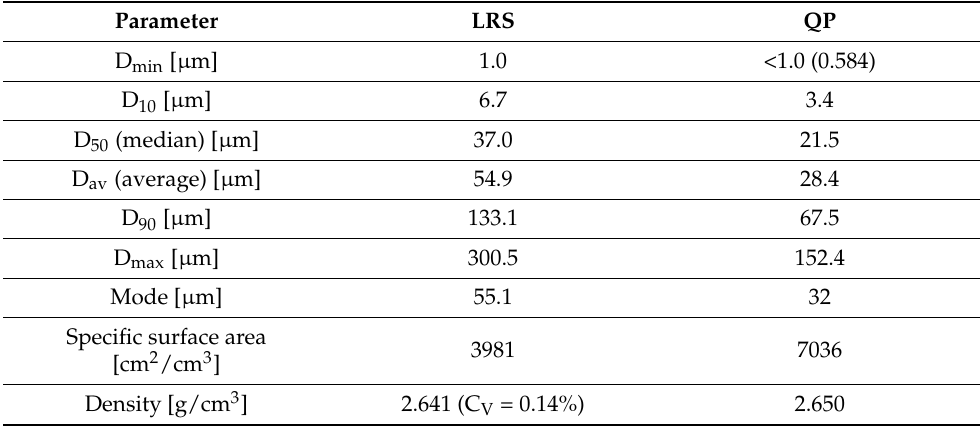
Table 4. Statistical parameters describing the particle size distribution, specific surface area, and density of regolith simulant (LRS) and quartz powder (QP).